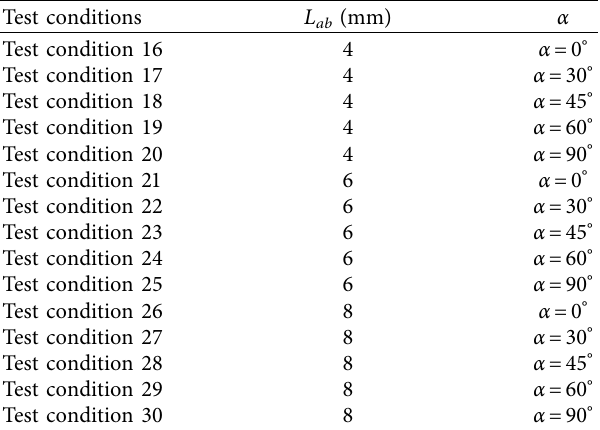
Table 3: Test condition B .